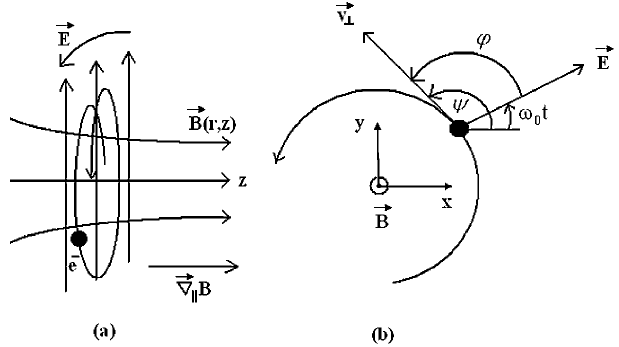
FIG. 2. (a) Mutual dispositions of the particle trajectory, elec- tric, and magnetic fields; (b) electron trajectory projection onto the transverse plane and definitions of the angles which charac- ¼ d c =dt , where c is the absolute terize the electron motion: ! c phase of the transversal velocity ~v ? , ’ is the angle between ~v ? and ~E .